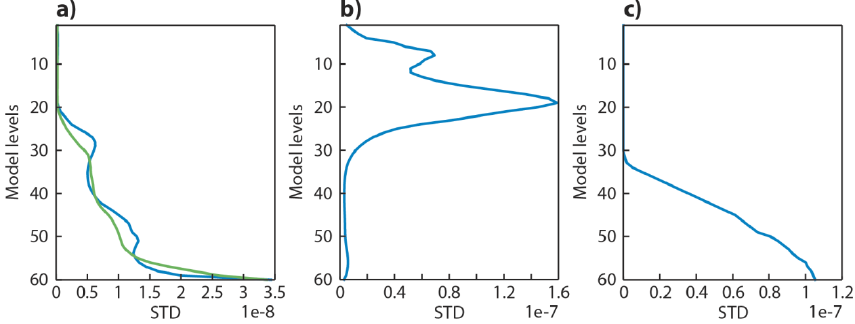
Figure 1. Background error SD profiles (blue) at 50 ◦ N, 10 ◦ E for (a) CO in kgkg − 1 , (b) O 3 in kgkg − 1 and (c) log(NO 2 ), dimensionless. Also shown in (a) is the profile for the CO background error SD of the original MACC system used in REAN